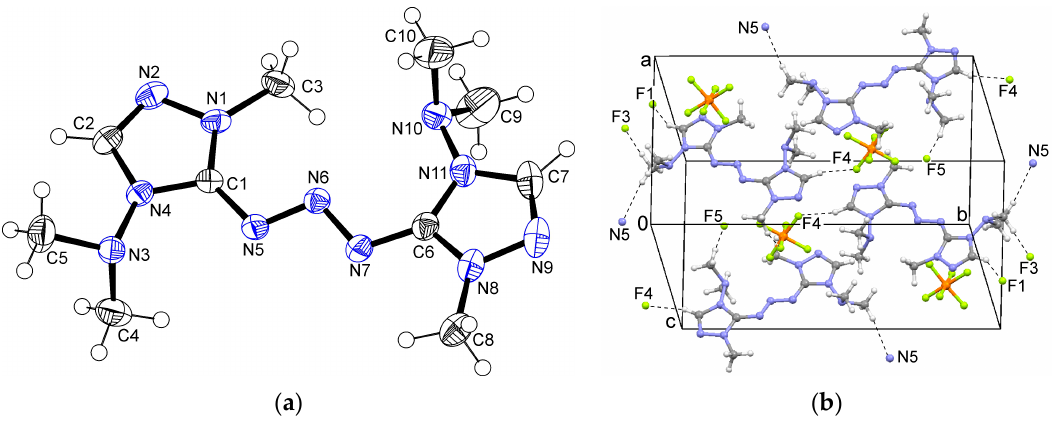
Figure 4. ( a ) O RTEP plot of the cation in 3 . ( b ) Packing in the crystal structure of 3 .